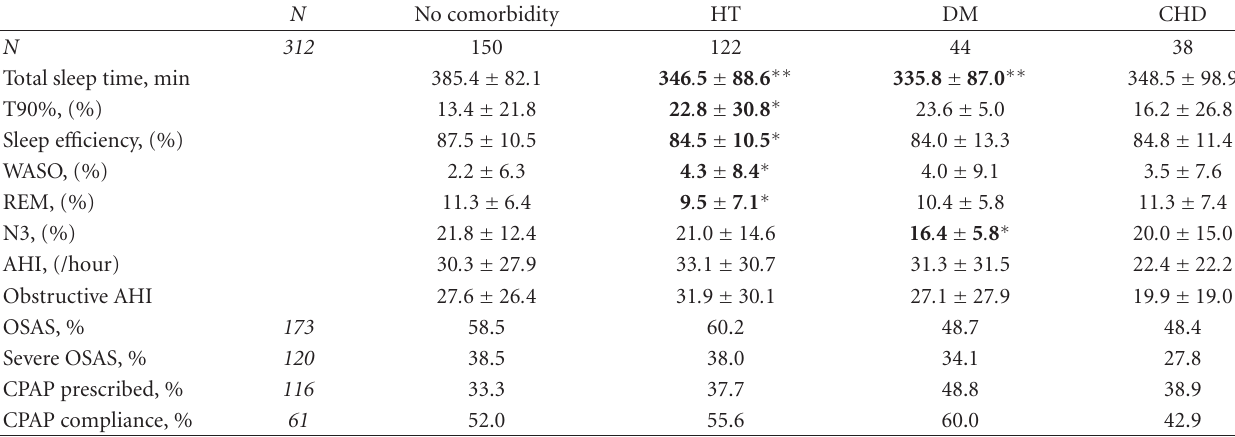
Table 2: Polysomnography findings and features of OSAS of the patients in di ff erent cardiovascular and metabolic comorbidity groups. N No comorbidity HT DM CHD N 312 150 122 44 38 Total sleep time, min 385 . 4 ± 82 . 1 346 . 5 ± 88 . 6 ∗∗